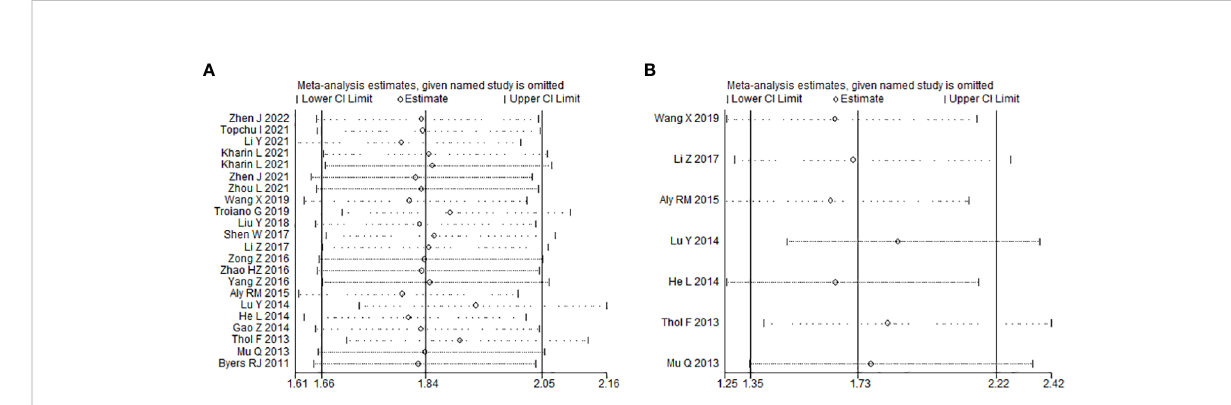
FIGURE 4 Effects of individual studies on pooled hazard ratios for MSI2 expression and survival of cancer patients. (A) Result of sensitivity analysis for pooled overall survival estimation. (B) . Result of sensitivity analysis for pooled disease-free survival estimation.